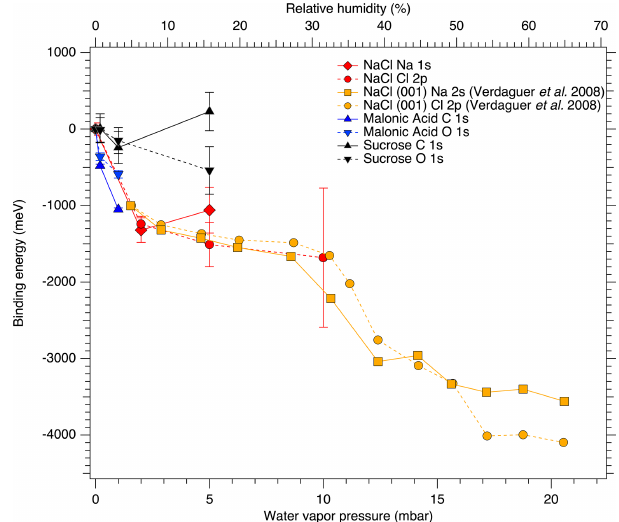
Figure 3. Binding energy shifts relative to dry conditions of the core-level peaks for NaCl, sucrose and malonic acid particles, as functions of water vapor pressure (relative humidity). The orange traces extending above 60% RH show the data from Verdaguer et al. (2008) for a single NaCl (001) crystal that has been aligned to the shifts obtained in this